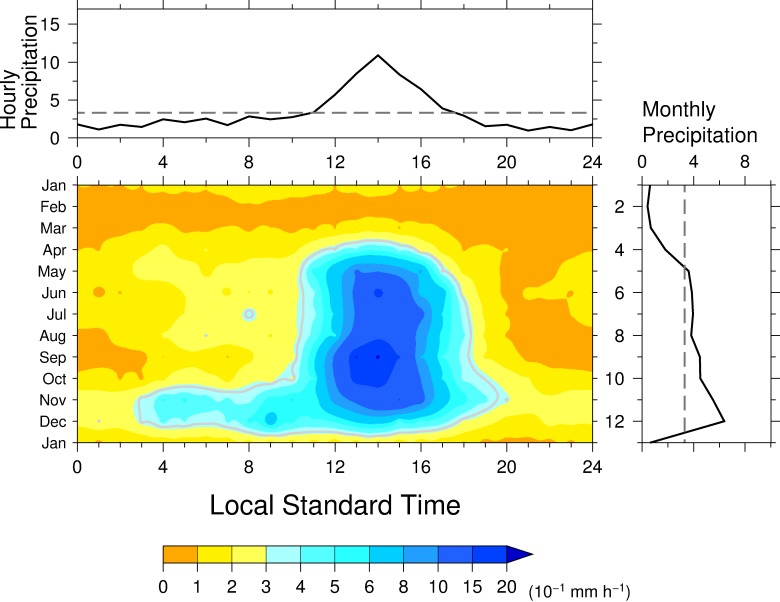
Same as in Fig 2 but for Río Piedras.